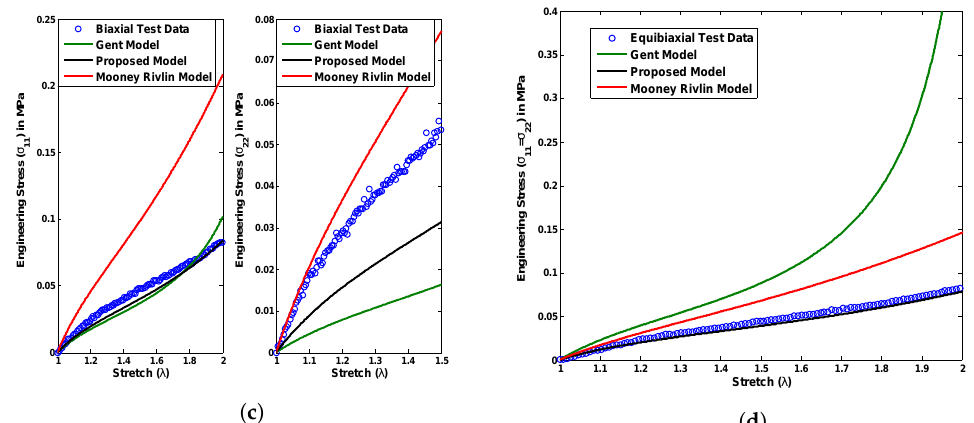
Figure 7. Experimental validation of the proposed model with Ecoflex test data compared to the existing material models under all possible deformation modes, ( a ) uniaxial, ( b ) pure shear, ( c ) biaxial, and ( d ) equibiaxial for a single set of material